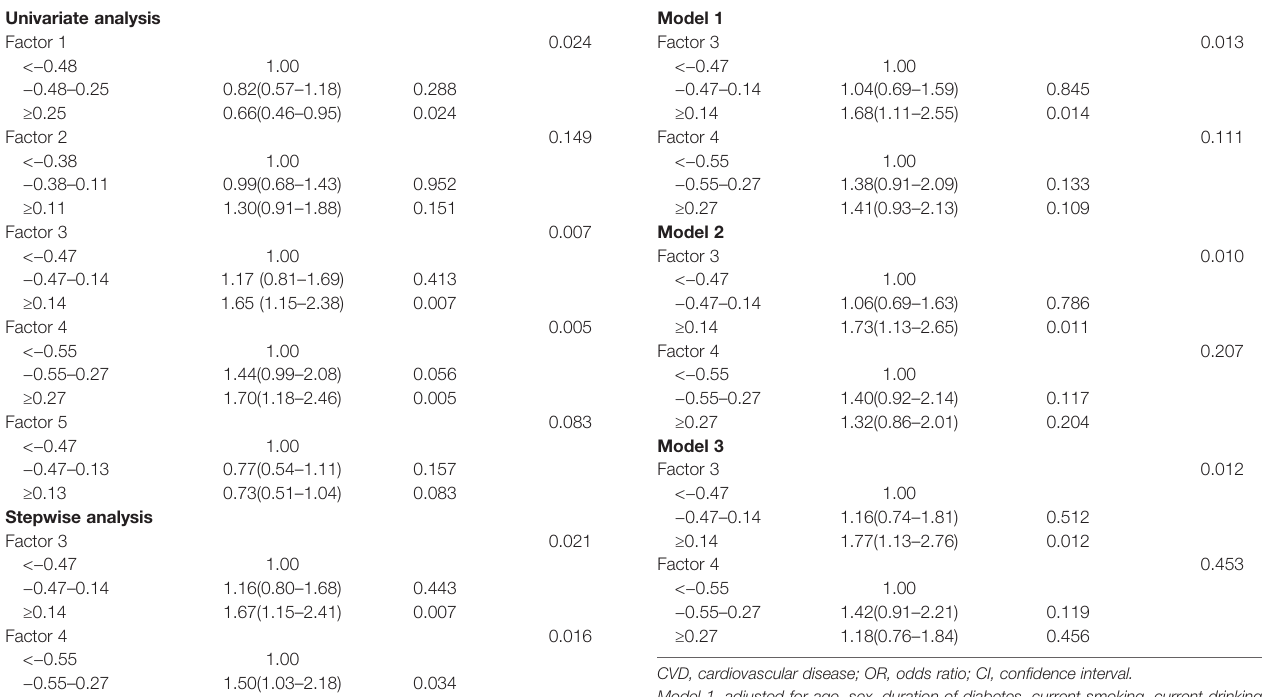
TABLE 4 | Odds ratio of extracted factors for CVD risk in T2D. OR(95%CI) P-value P for trend Univariate analysis Factor 1